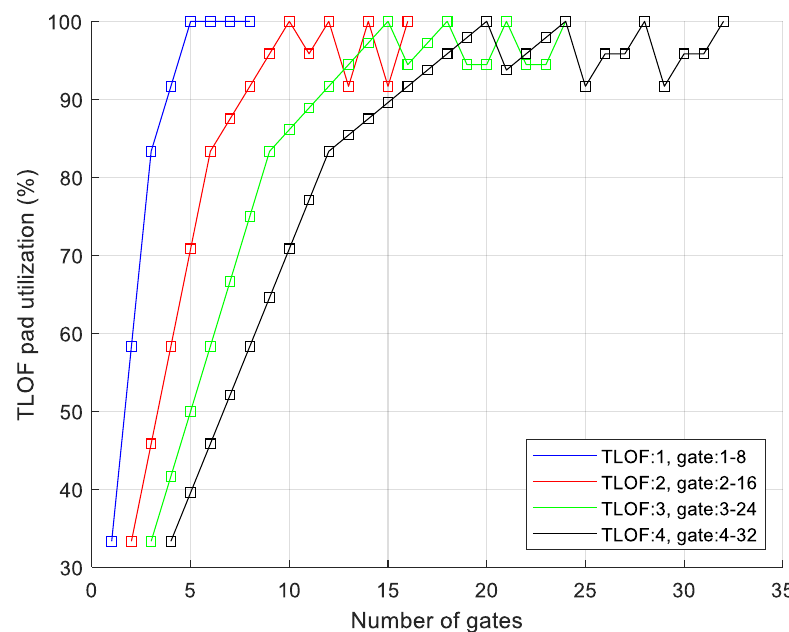
Figure 44. TLOF pad utilization according to TLOF pad and gate ratio.